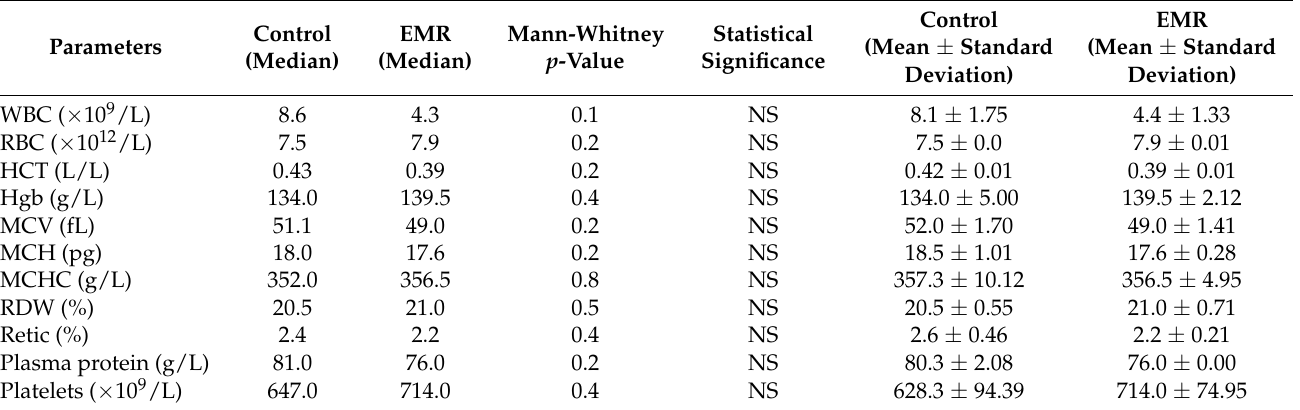
Table 1. Effect of 150 kHz IF EMR on haematological parameters in SD rats after 2-month whole body exposure.